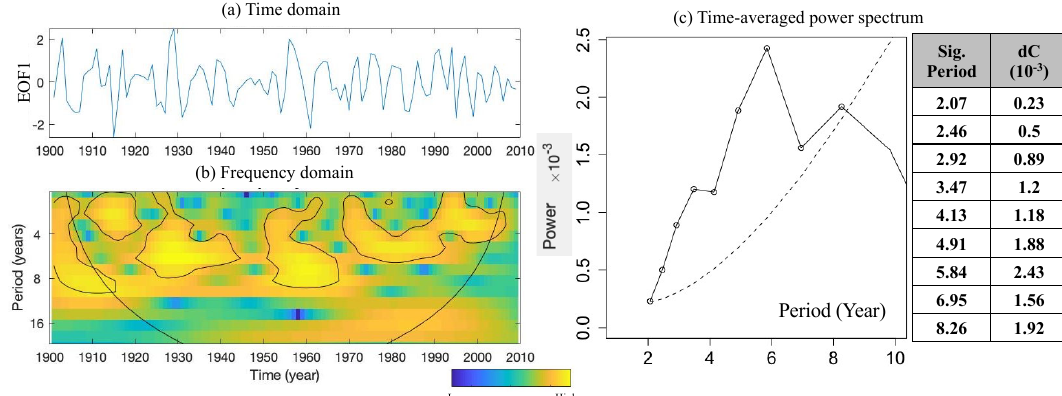
Figure 5. The time − averaged power spectrum from Morlet wavelet transform of empirical orthogonal function (EOF, m = 2): ( a ) the EOF1 from the inter-annual climate component; ( b ) power spectrum of the wavelet transform coefficient for the reconstruction of the EOF1 (significant regions are surrounded by black isolines); and ( c ) time-averaged power spectrum. The periods (dots) which pass the significance test at the 0.05 significance level are listed and classified, including the biennial annular mode oscillation (BAMO), the quasi-biennial oscillation (QBO) and the El Niño–Southern Oscillation (ENSO).